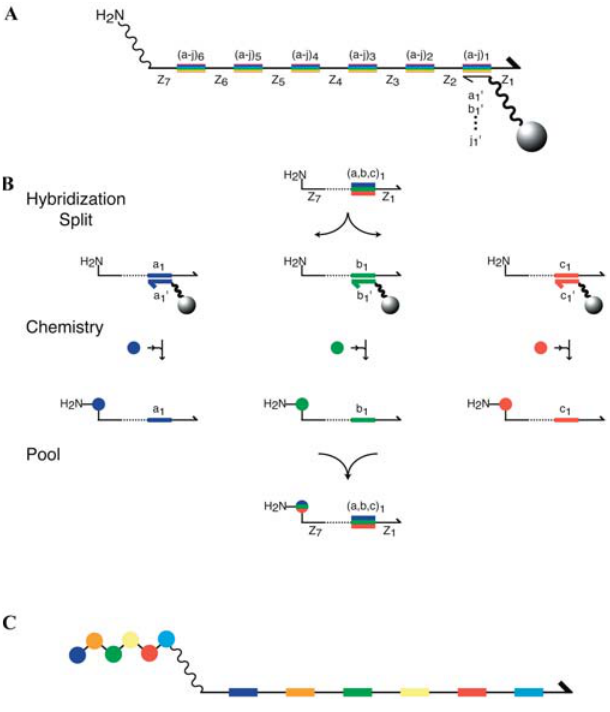
Figure 3. Chemical Translation (A) Schematic showing the structure of the DNA support library. Small molecules are synthesized at the 5 9 end of 340-base ssDNA genes. The ssDNA consists of 20-base noncoding regions (black lines labeled Z 1 –Z 7 ) and 20-base coding positions (colored bars labeled [a–j] 1–6 ). All library members contain the same seven DNA sequences at the seven noncoding regions. At each of the six coding positions, ten mutually exclusive DNA codons, (a–j) n , are present, for a total of 60 different sequences. Each coding region specifies the addition of a single subunit to a growing small molecule. A unique reactive site (in this case a primary amine) for small-molecule synthesis is attached to the 5 9 end of the ssDNA through a polyethylene glycol linker (squiggly line). Resin beads coated with an oligonucleotide complementary to one codon (anticodon beads, gray ball at right) capture by hybrid- ization ssDNAs containing the corresponding codon. (B) Chemical translation is a split-and-pool synthesis, with splitting directed by DNA hybridization. A ssDNA library is hybridized to a set of anticodon columns (gray balls) corresponding to the set of codons present at a single coding position. The ssDNA genes partition into subpools based on sequence identity. Distinct chemical subunits (colored balls) are coupled to the DNA in each subpool. Finally, the DNA is repooled, completing the encoded addition of one subunit to the growing small molecule. The process of hybridization splitting, chemistry, and pooling is repeated for all subsequent coding regions. (C) Schematic product of chemical translation. The sequence of the small-molecule subunits (colored balls) corresponds to the sequence of codons (colored bars) in the ssDNA gene. DOI: 10.1371/journal.pbio.0020174.g003